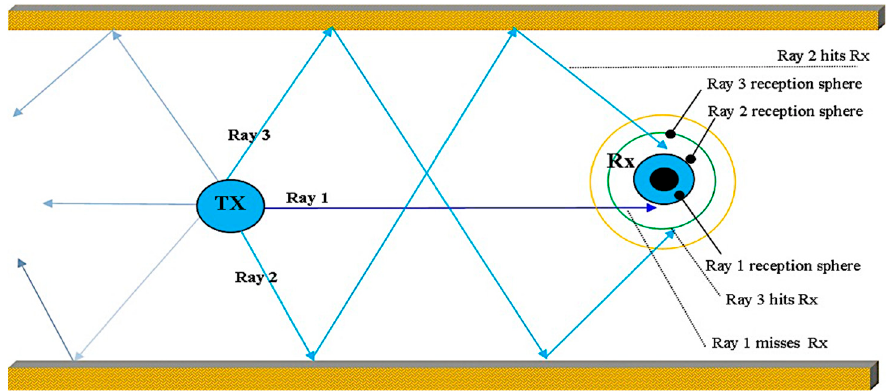
Figure 2. Graphical view of shooting bouncing ray tracing (SBRT) method in an indoor scenario.